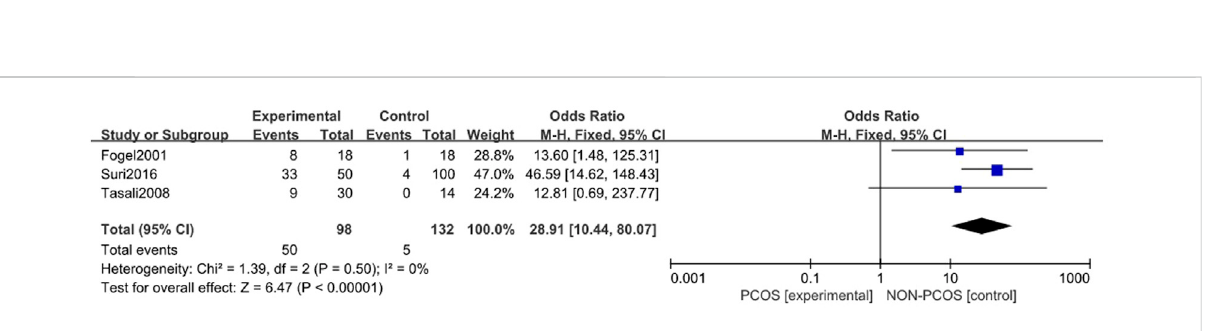
FIGURE 3 Forest plot of incidence of sleep disturbance in PCOS group and control group (after removing heterogeneity studies).